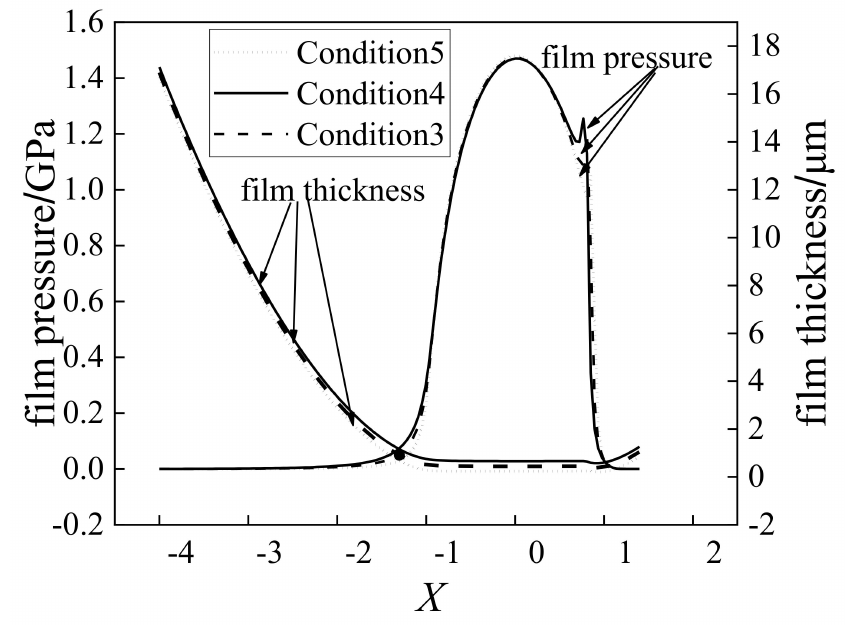
Figure 6. Influence of velocity on film thickness